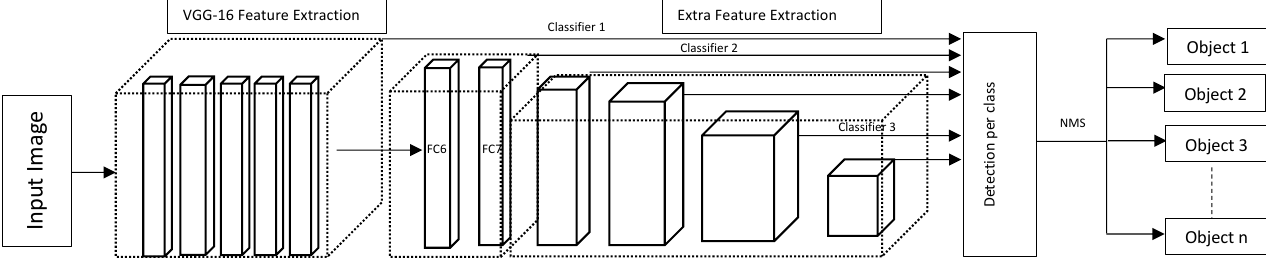
Figure 7. Architecture of the SSD model.